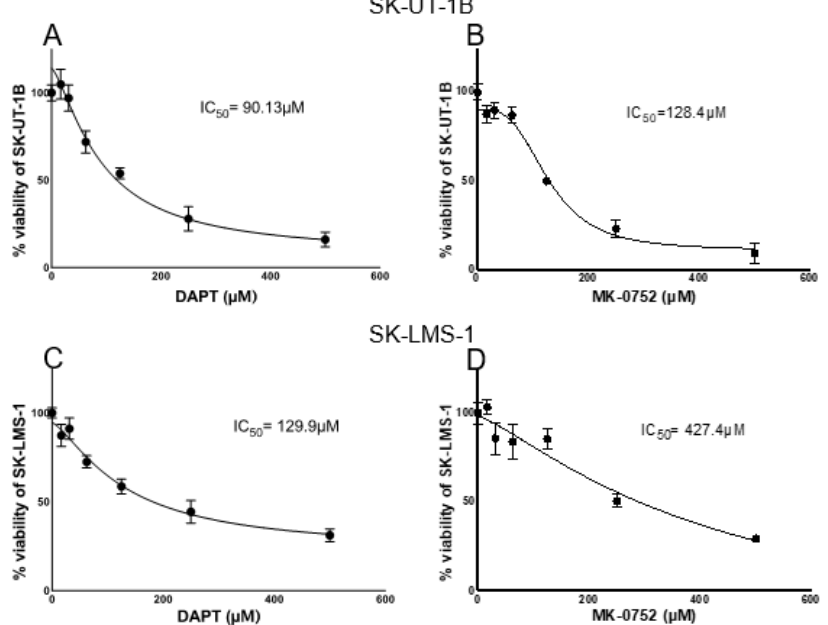
Figure 4. Dose–response curves for inhibitory concentrations. Half maximal inhibitory concentrations (IC 50 ) were determined and utilized to determine IC 5 and IC 30 used for treatment. Graphs of SK-UT-1B treated with DAPT ( A ) and MK-0752 ( B ) and SK-LMS-1 treated with DAPT ( C ) and MK-0752 ( D ).